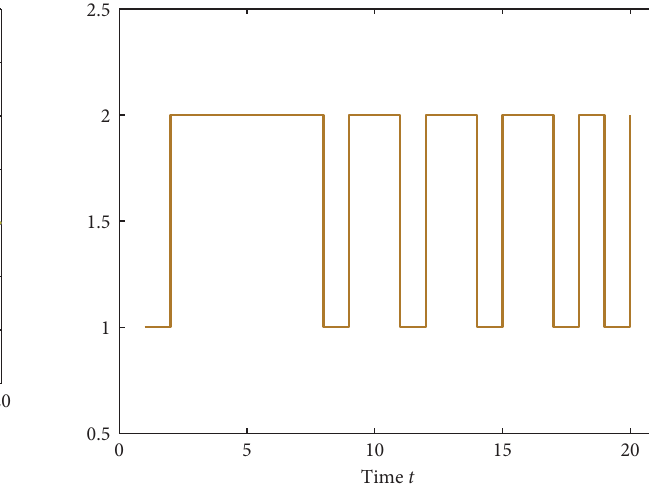
Figure 5: Mode transitions of semi-Markov jump CDNs.